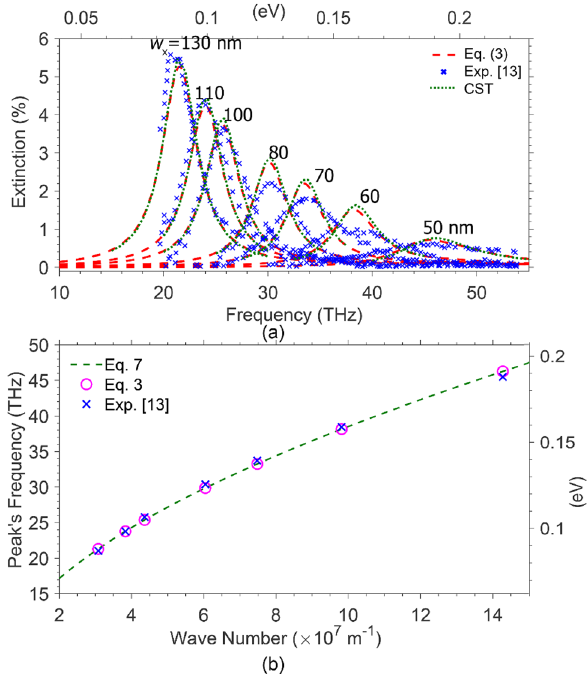
Figure 2. ( a ) Extinction spectra of graphene ribbons of widths 50 nm ≤ w x ≤ 130 nm, pitches d x = 2w x and μ C = 0.3 eV on DLC substrate. The red dashes represent data obtained Eqs. (3) and (6) with β = 529 μm −2 , to fit the experimental data 13 (blue crosses). The data shown by the green dots are the results from CST simulations. ( b ) The plasmons peak’s frequency versus the wave vectors, q , obtained from (3) as shown 1(a) (open circles), from the experimental data 13 (crosses), and Eq. (7)